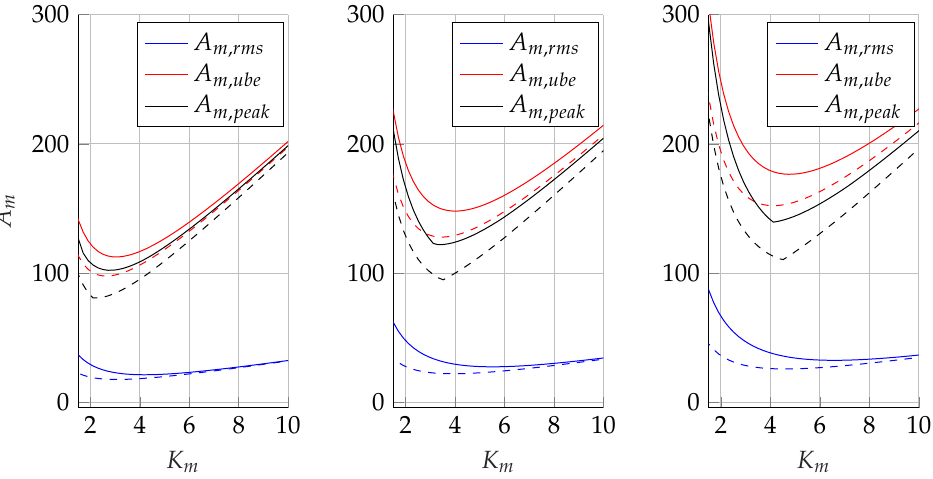
Figure 14. Load curves sensitivity analysis for axis 1 at different payloads (from left to right 0, 2 and 4 kg). Using the same color coding, the dashed lines represent an exclusively dynamic loading condition, while the continuous lines take into account also the static